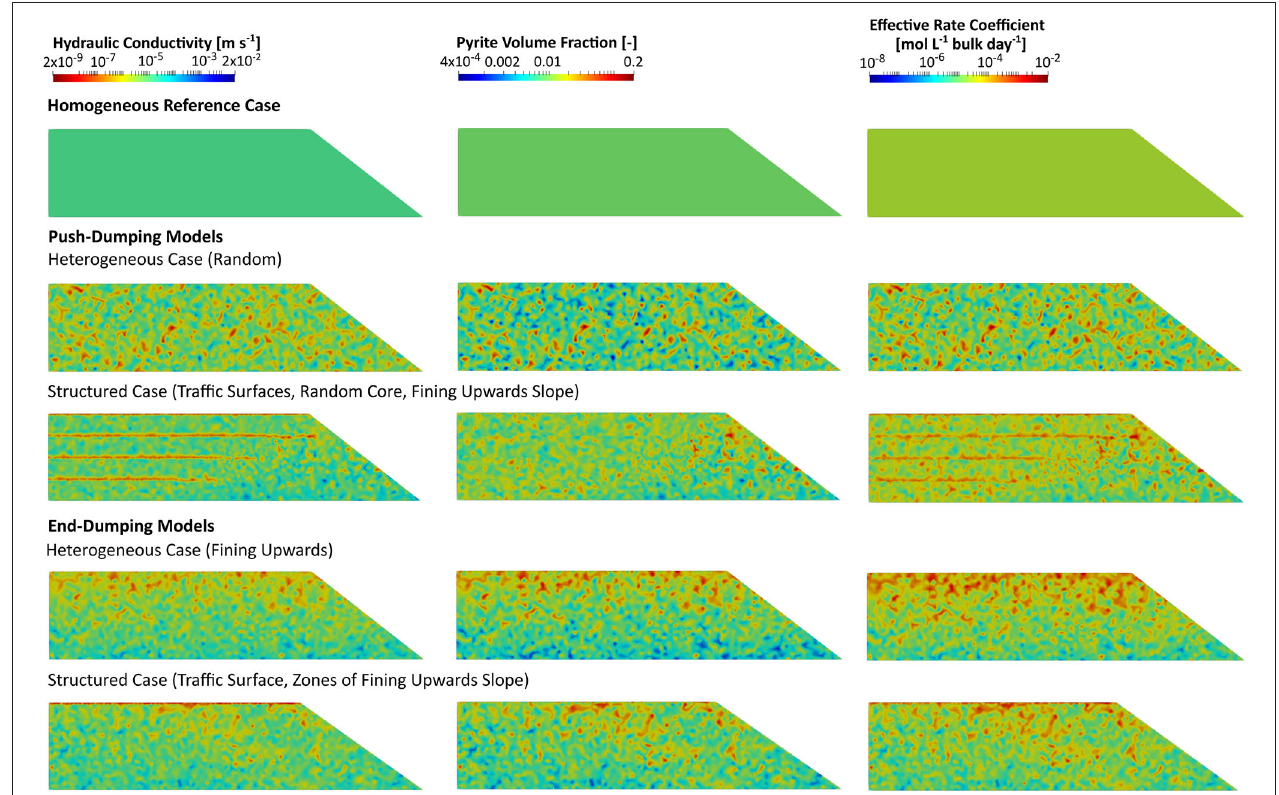
FIGURE 3 | Cross-sections showing the initial conditions for the single bench models including spatial distributions of hydraulic conductivity, pyrite volume fraction, and effective rate coefficients for pyrite within the pile for various scenarios. For the heterogeneous case (random and fining upwards), one of the five configurations that was used to test parameter sensitivity is shown. Porosity is also spatially varied following the relationship to hydraulic conductivity shown in Equation 2. Histograms showing the nodal distribution for these parameters are shown in Supplementary Figure 4 .